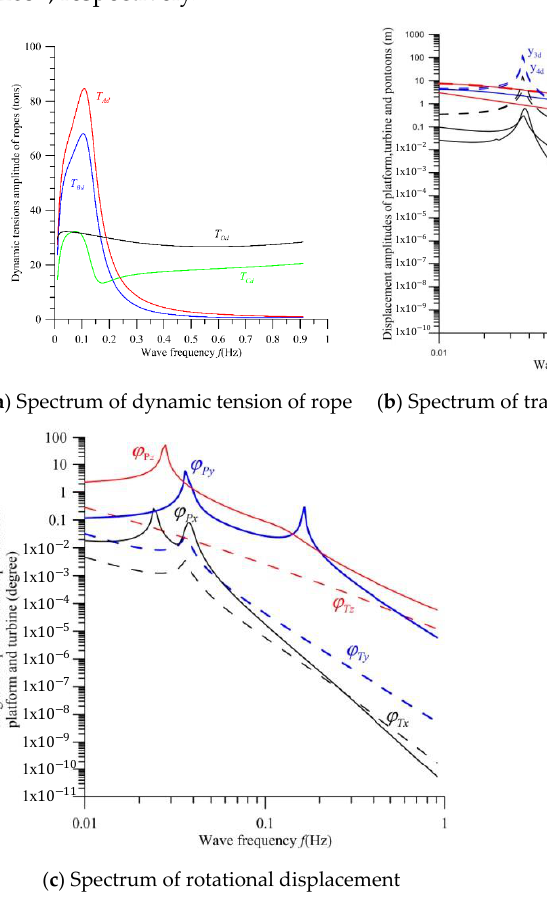
Figure 11. Spectrums of dynamic response.